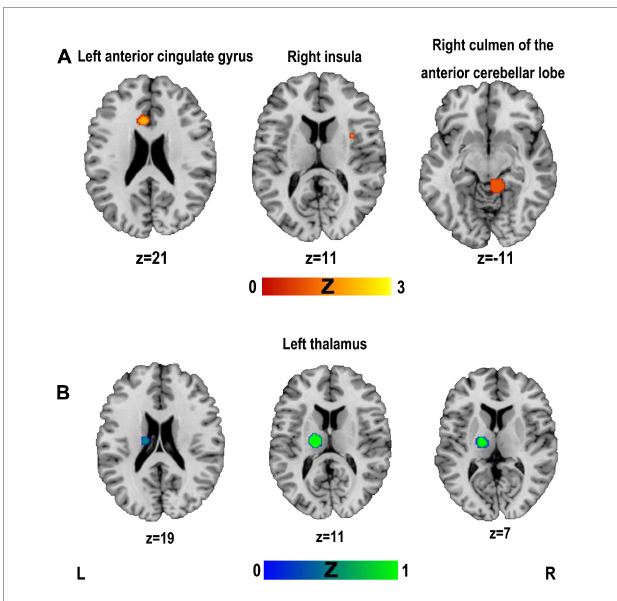
FIGURE3 Clusters superimposed on Montreal Neurological Institute (MNI) spatial templates for functional MRI activation likelihood estimation (ALE) meta-analysis. (A) The cluster with hyperactivation; (B) the cluster with